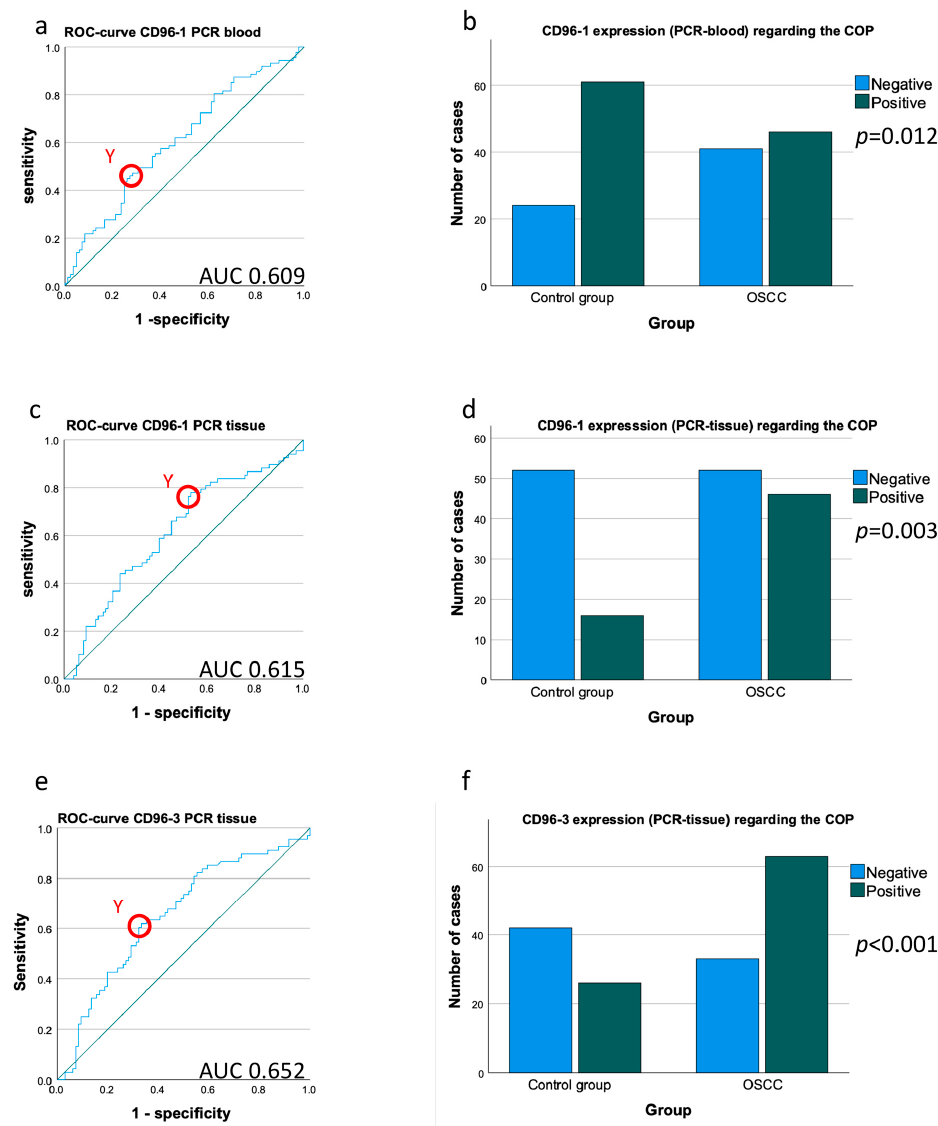
Figure 3. Determination of a cut-off point and allocation of individual cases to a group (controls vs. OSCC patients) based on CD96 mRNA expression. ( a , c , e ) ROC curves for CD96 mRNA expression based on the ∆ CT data. The diagrams are a plot of the sensitivity (true-positive rate) vs. 1-specificity (false-positive rate) over all possible ∆ CT values. The circles show the points of the highest Youden (Y) indices which are associated with the COP (OSCC patients vs. controls). The AUC value is indicated. ROC: receiver operating characteristic, COP: cut-off point, AUC: area under the curve. ( b , d , f ) Division of the test and control group (group OSCC patients and group controls) into positive and negative subgroups based on the ascertained COPs of CD96 expressed as ∆ CT values. Using the χ 2 test, the specimens were positively (malignant) judged if the values lay above the COP (decreased expression) in blood samples ( a ) and below the COP (increased expression) in tissue samples ( d , f ). Decreased CD96 expression levels in the peripheral blood ( b ) and increased CD96 expression levels in the tissue of OSCC patients ( d , f ) compared to the healthy oral mucosa of volunteers were significant. Therefore, the COP may be a parameter allowing the allocation of a blood or tissue sample to a group and an indication of malignancy. ( a ) ROC curve for CD96 transcript variant 1 in peripheral blood samples. ( b ) χ 2 test for CD96 transcript variant 1 in peripheral blood samples. ( c ) ROC curve for CD96 transcript variant 1 in tumor tissue and mucosa samples. ( d ) χ 2 test for CD96 transcript variant 1 in tumor tissue and mucosa samples. ( e ) ROC curve for CD96 transcript variant 3 in tumor tissue and mucosa samples. ( f ) χ 2 test for CD96 transcript variant 3 in tumor tissue and mucosa